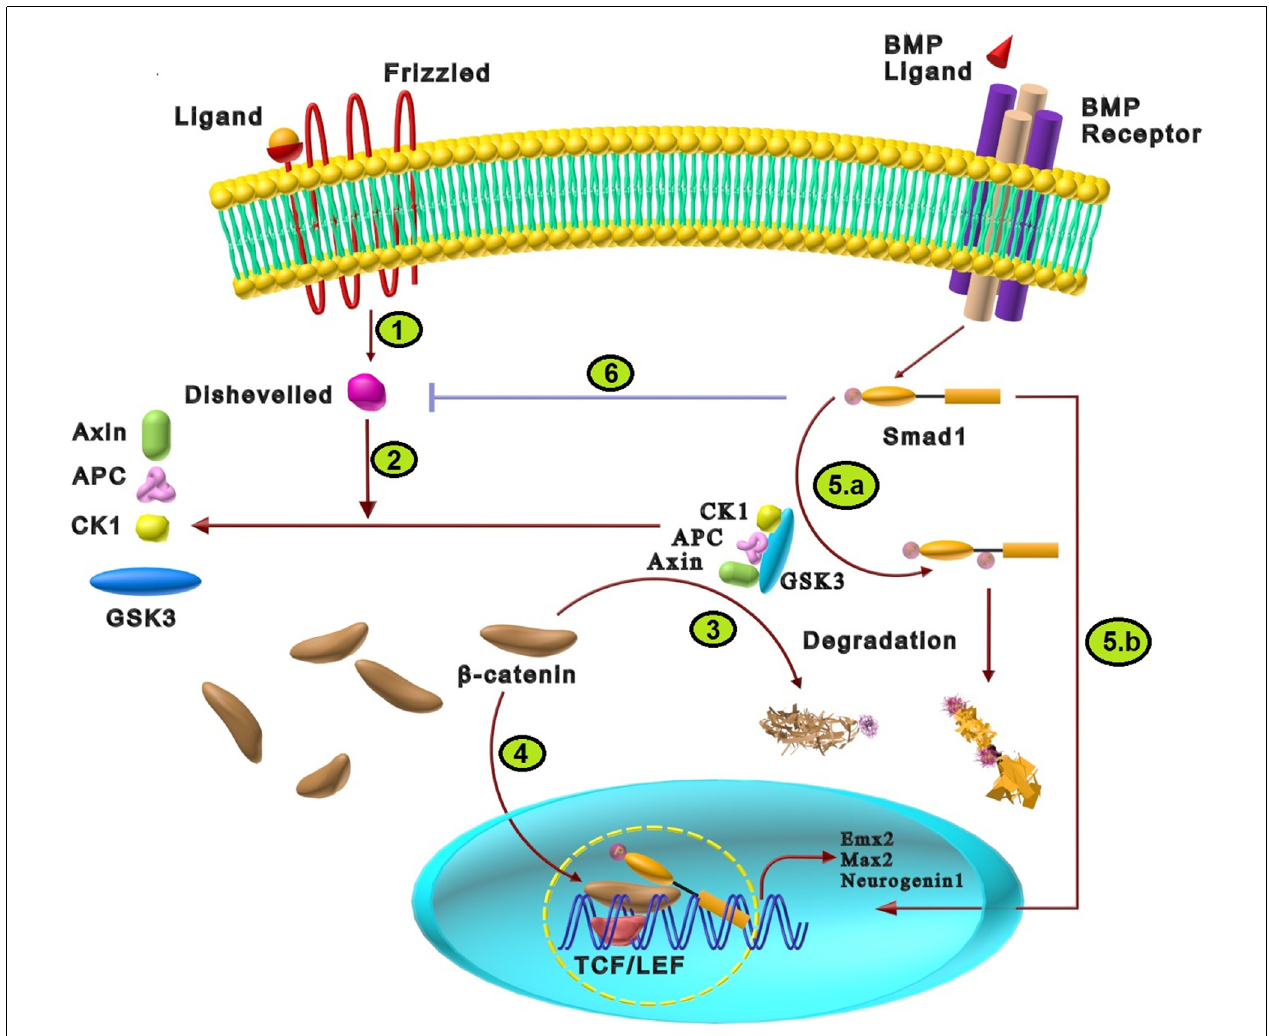
FIGURE 6 | The cross-talk between BMP and Wnt signaling pathways in neural differentiation. (1) Wnt signaling initiation results from the interaction of Wnt ligand with the N-terminal extra-cellular cysteine-rich domain of a Frizzled (Fz) family receptor that activates disheveled. (2) Activated disheveled changes the destructive protein complex containing axin, APC, GSK3, and CKI α , resulting in GSK3 suppression. (3) Normally, the destructive complex inhibits β -catenin via the degrading effects of GSK3. Wnt-induced alteration of this complex increases the stability of β -catenin. (4) Stabilized β -catenin is translocated into the nucleus and activates TCF/LEF transcription factors that regulate the expression of Wnt target genes such as neurogenin 1, Emx2, and Max2, which induce neural fate determination. (5) Probable mechanisms for synergistic effects of Wnt and BMP: (a) Wnt inhibits GSK3 phosphorylation effects on specific sites of Smad1 in the linker region that stabilizes Smad1 and enhances BMP signaling. (b) Smads can directly collaborate with the β -catenin/TCF/LEF transcription complex that synergistically regulates the transcription of target genes such as neurogenin 1, Emx2, and Max2. (6) In the absence of any ligands, Smad1 binds and inhibits disheveled-1. The presence of BMP2 increases phosphorylated Smad1, which increases the inhibitory interaction between disheveled-1 and Smad1 that finally suppresses Wnt signaling